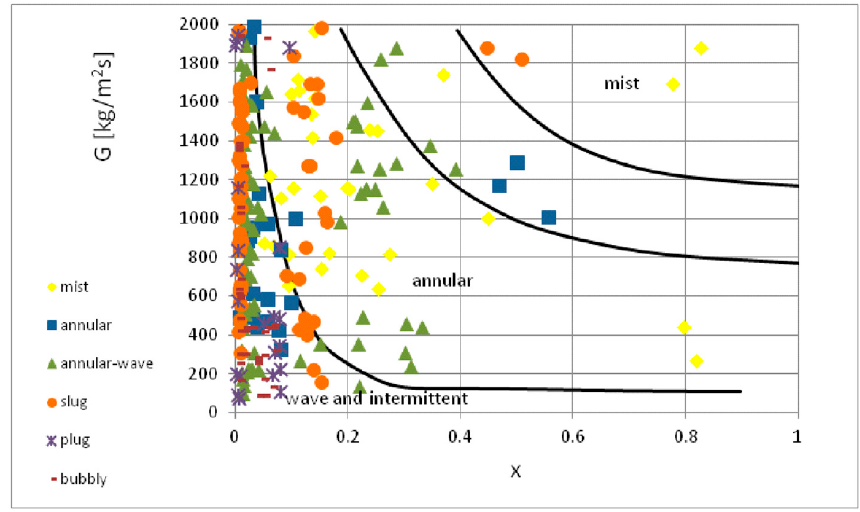
Figure 21. Comparison of the author’s experimental research results with the map of two-phase flow structures according to map of Soliman [42].